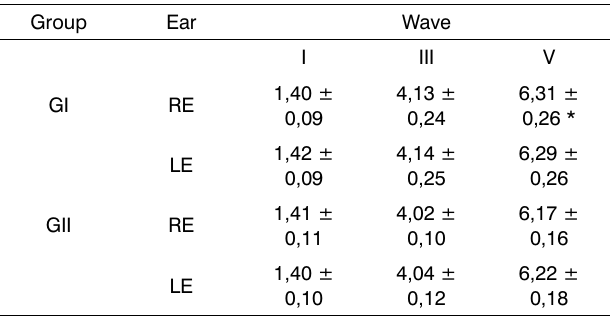
Table 1. Mean and standard deviation of absolute latencies of waves